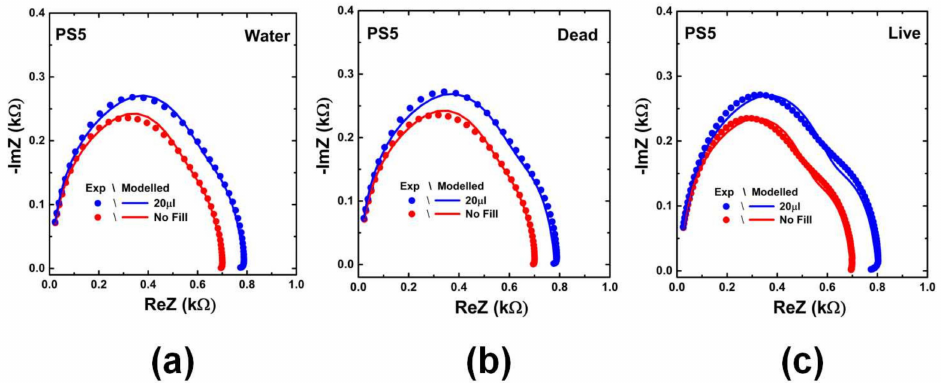
Figure A1. Measured (dots) and modeled (solid line) Nyquist plots of the three 1 × 1 cm 2 large impedance chip PS5 ( a ) with No fill condition (in red color) and ( b ) with addition of 20 µ L Dl water (in blue color) used to investigate impedance changes by adding 1, 2, 3, 4, and 5 µ L DI water ( a ) without cells, ( b ) with dead cells, and ( c ) with live cells. Modeled parameter values from equivalent circuit model shown in Figure 5b are listed Table A1. Increase in the real part of impedance |Z| of PS5 chips from 0.7 k Ω to 0.8 k Ω with addition of 20 µ L Dl is caused by the increase in inner ring resistance components (R Au/liq , R liq , and R j ) as listed in Table